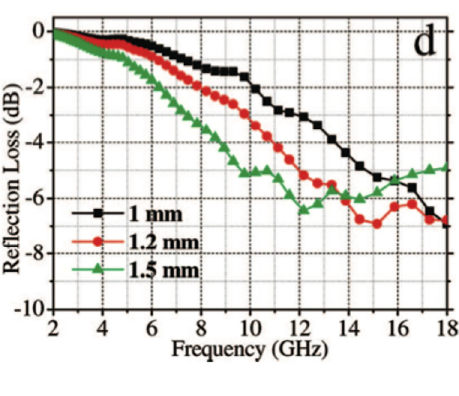
Figure 21. The reflection loss of different thicknesses of twisted carbon filament composites [58]. Reprinted with permission from [58], Copyright 2008 American Chemical